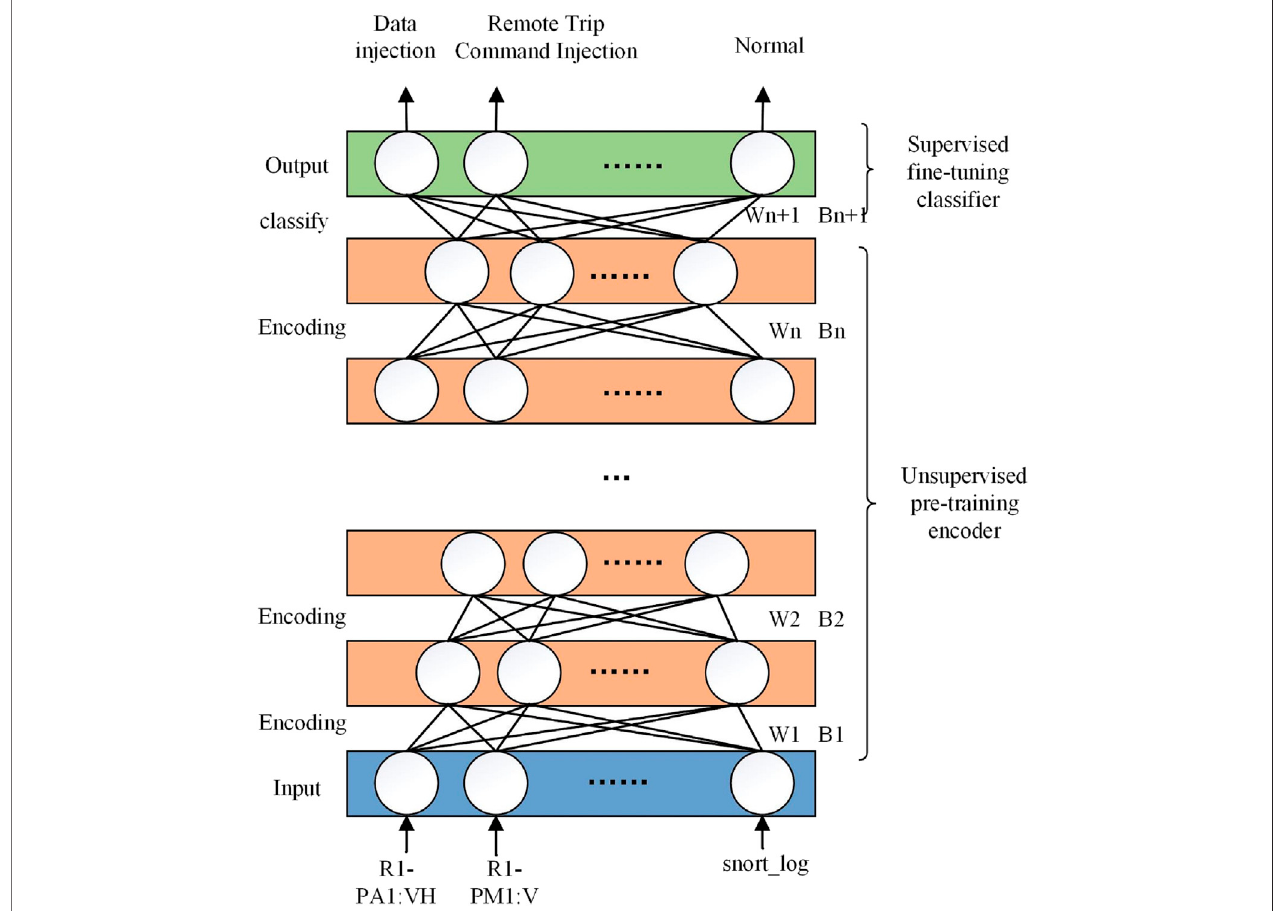
FIGURE 1 | SAE detection model